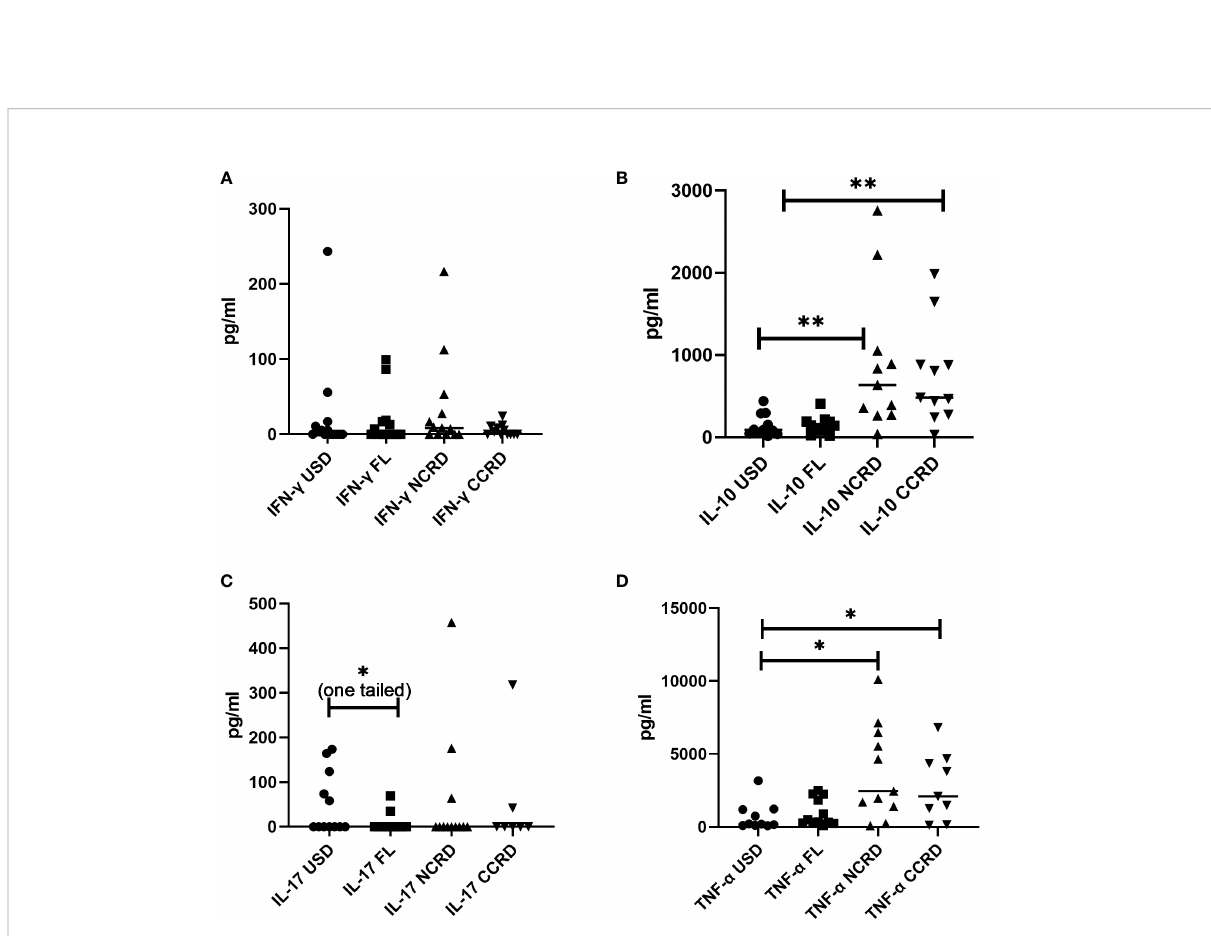
FIGURE 6 The levels of (A) IFN- g , (B) IL-10, (C) IL-17, and (D) TNF- a (pg/ml) plotted on the Y -axis in the supernatants of PBMCs stimulated with the full- length Gal-9 and individual CDRs (shown on the X -axis) as assessed by the Luminex assay. Individual values are plotted as scatter plots, and the horizontal line represents median values. p -values showing signi fi cant differences ( p < 0.05) between unstimulated (USD) and treated cells as calculated by the Wilcoxon signed-rank test are shown. *p < 0.05, **p <